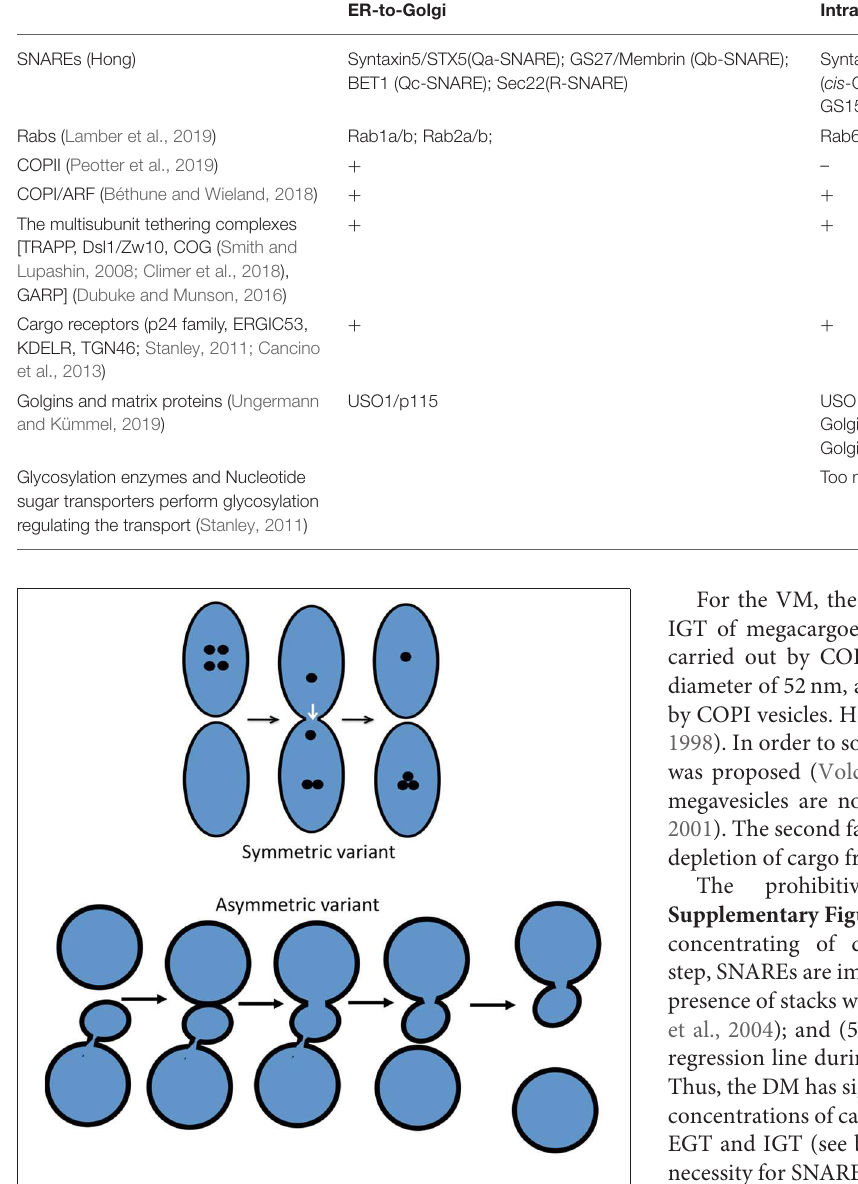
FIGURE 1 | Scheme showing the two variants of the KARM: symmetric and asymmetric. In the asymmetric case (bottom), the cargo domain and a cellular compartment are separated by a thin tubule. Fusion takes place in one site, and fission occurs in another site where this tubule is localized. To function more precisely, it is important to concentrate SNAREs over the cargo domain, which then fuses with the distal compartment (the upper